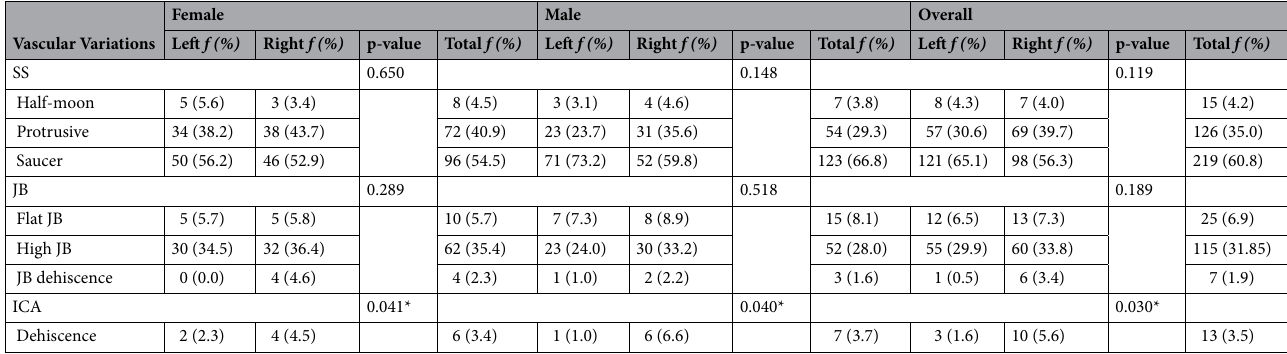
Table 5. Incidence of anatomical variations of the sigmoid sinus, jugular bulb, and internal carotid artery. X 2 , significant different at *p < 0.05. f frequency, % percentage, SS sigmoid sinus, JB jugular bulb, ICA internal carotid